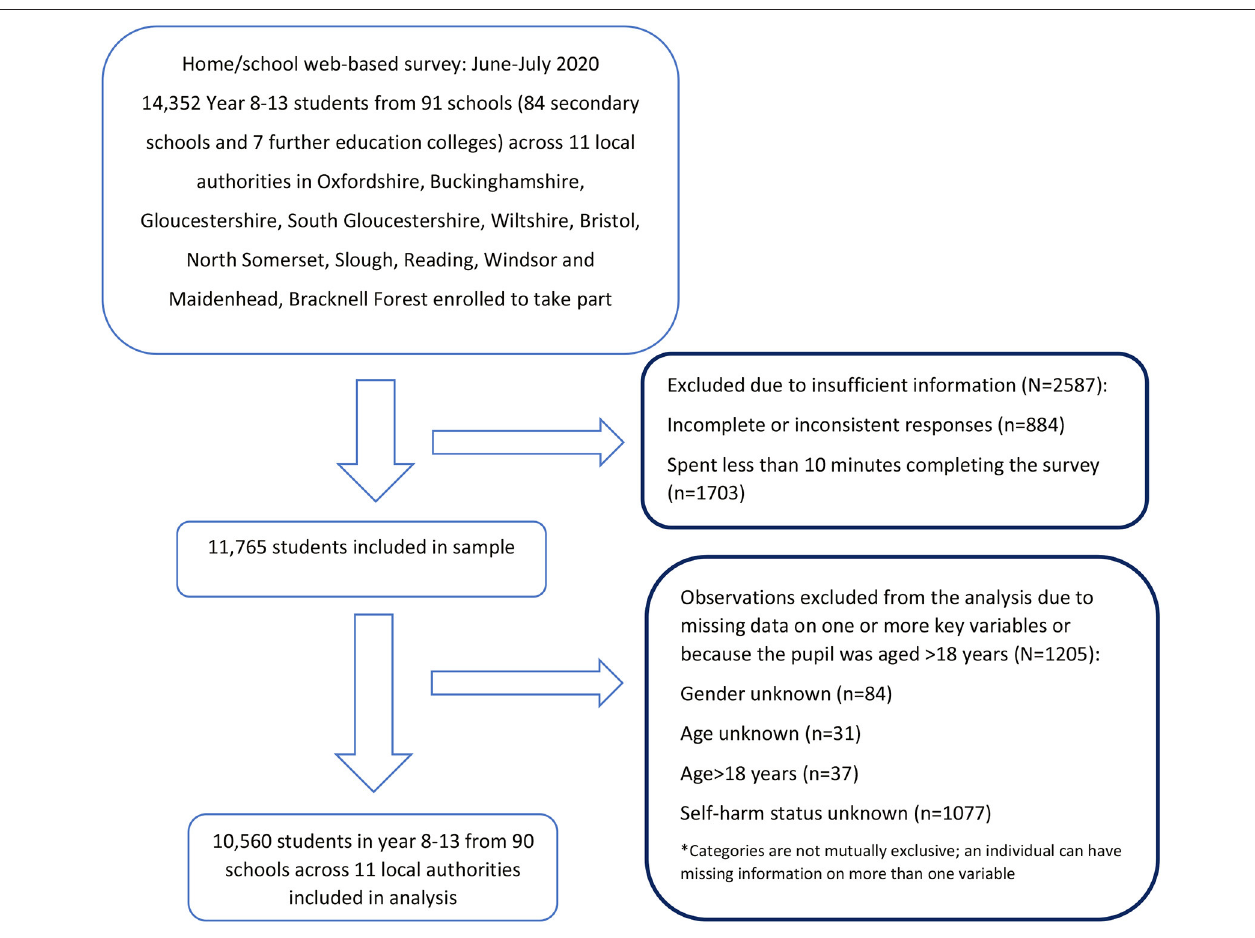
FIGURE 1 | Sample selection